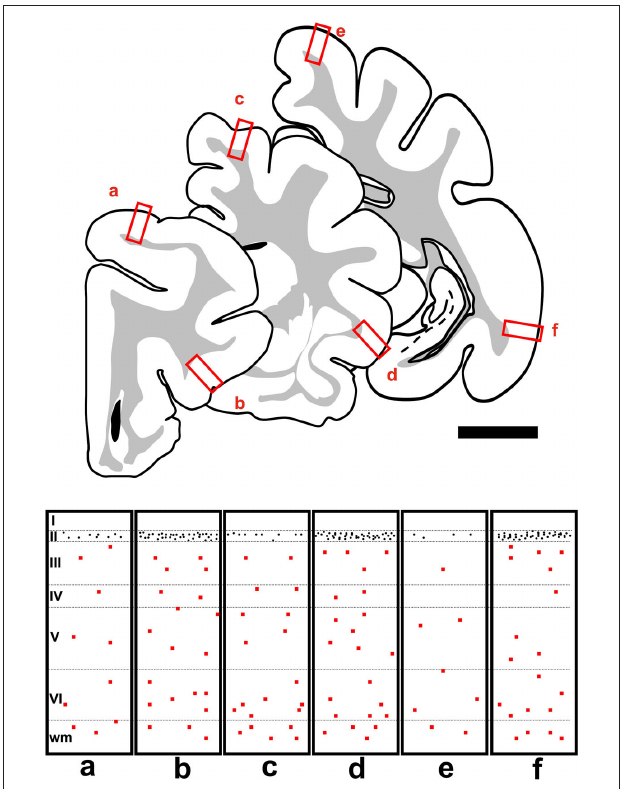
Figure 1 | Camera lucida drawings showing three representative 50 μm coronal sections covering the rostral to caudal extent of the cat cerebral cortex, located +5, −1, and −12 mm from Bregma (reinoso-Suarez, 1961). Rectangles in the bottom of the figure (a–f) are schematic representations of the distribution of PSA-NCAM expressing cells in the squared regions of the three coronal sections. The somata of PSA-NCAM expressing S cells in layer II are indicated by black dots and those of L cells by red squares. Scale bar: 5